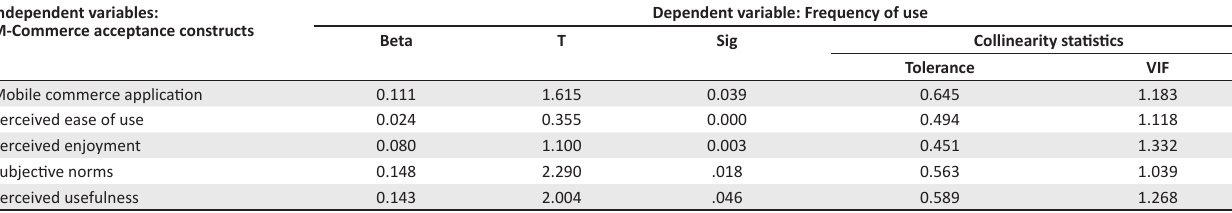
TABLE 4: Regression analysis: Mobile-commerce acceptance and frequency of use. Independent variables: M-Commerce acceptance